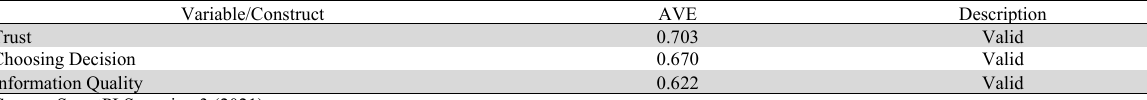
Result of Discriminant Validity Test with AVE